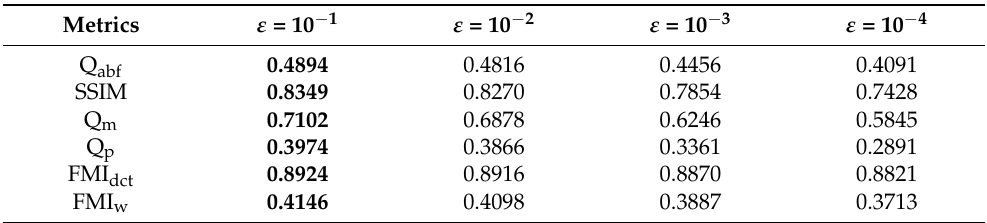
Table 2. Averages of the six metrics for different ε on ten pairs of source images from two public datasets. Numbers in bold font represent the best value.